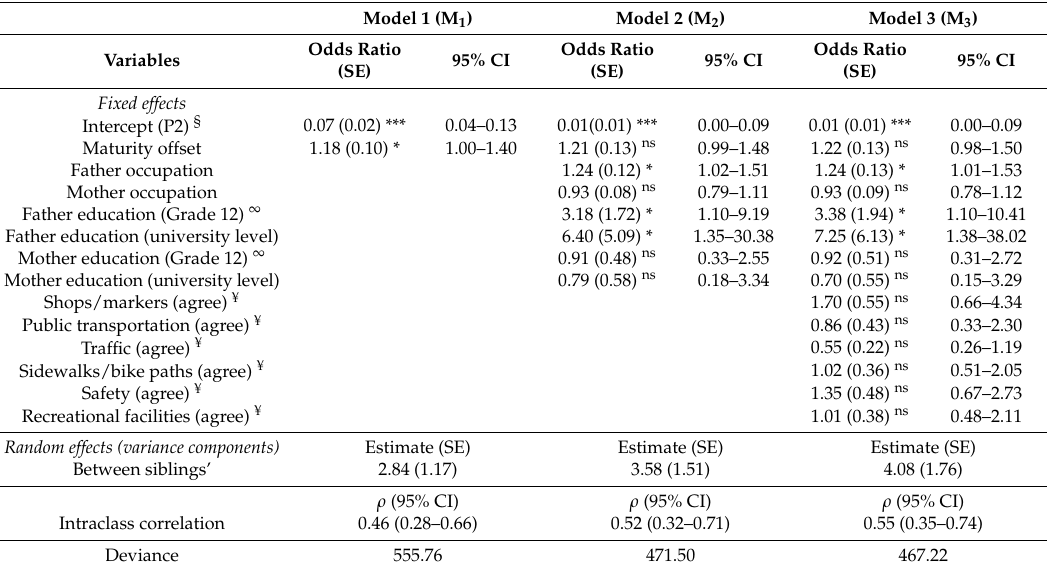
Table 3. Multilevel logistic regression in siblings profile